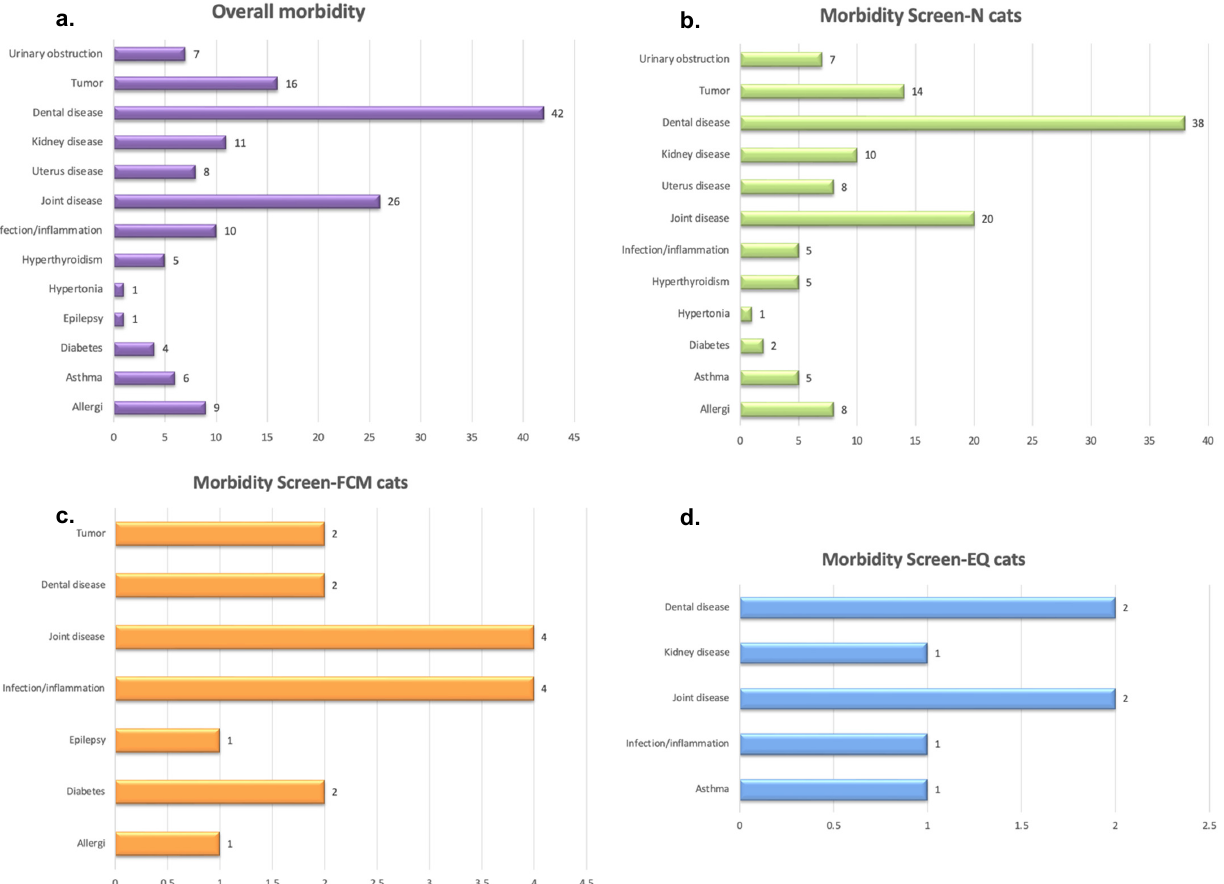
Figure 4. ( a ) Overall non-cardiac morbidity in the total study population reported by owners (n = 139/1113, 12.5%), ( b ) Morbidity in cats with Screen N (n = 118/139, 84.9%), ( c ) Morbidity in cats with Screen FCM (n = 15/139, 10.8%), ( d ) Morbidity in cats with Screen EQ (n = 6/139, 4.3%). No diagram is